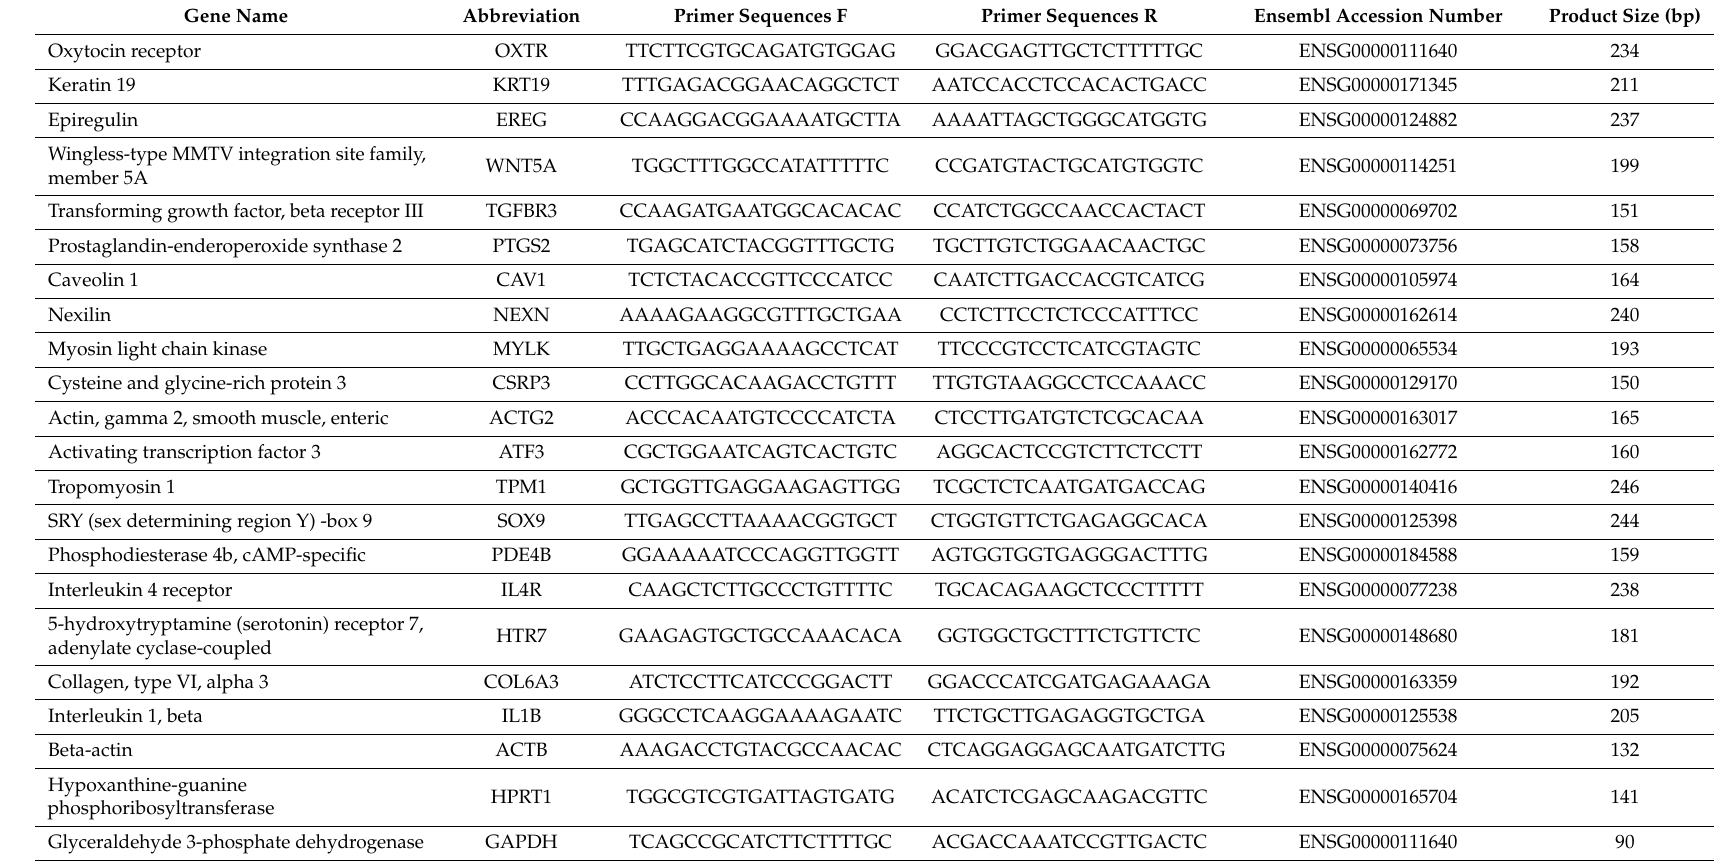
Table 1. The sequences of primes used for RT-qPCR